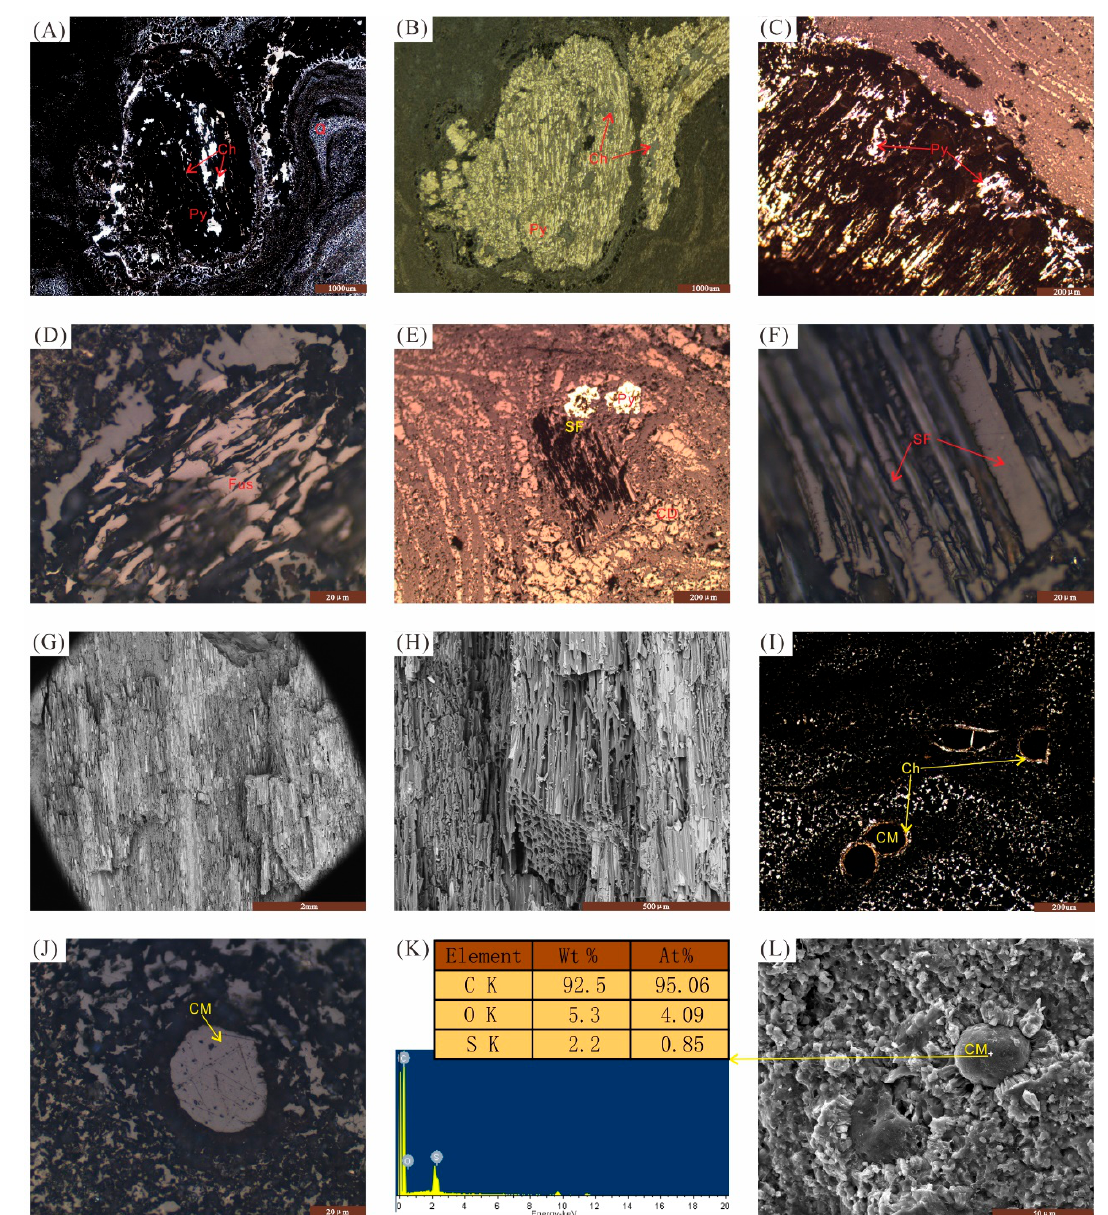
Figure 7. Charcoal and carbon microparticles in coal. ( A ) Pyritized fusinite embedded within collodetrinite in PPL; ( B ) Photomicrographs of ( A ), reflected light in air; ( C ) Inertinite (linear) under reflected light (dry objective); ( D ) Pyrofusinite with well-preserved cell structure under reflected light (oil immersion); ( E ) Inertinite associated with clay minerals under reflected light (dry objective); ( F ) Magnification of ( E ), semifusinite with well-preserved cell structure under reflected light (oil immersion); ( G ) Micrograph of charcoal SEM BSED; ( H ) Magnification of ( G ), transverse view of a fragment of charcoal, showing homogenized cell walls and three-dimensional cellular preservation SEM BSED; ( I ) Carbon microparticles in PPL; ( J ) Carbon microparticle under reflected light (oil immersion); ( K ) EDS data for carbon microparticle; ( L ) Carbon microparticle SEM ETD. Py, pyrite; Q, quartz; Ch, chamosite; Fus, fusinite; SF, semifusinite; CM, carbon microparticle.